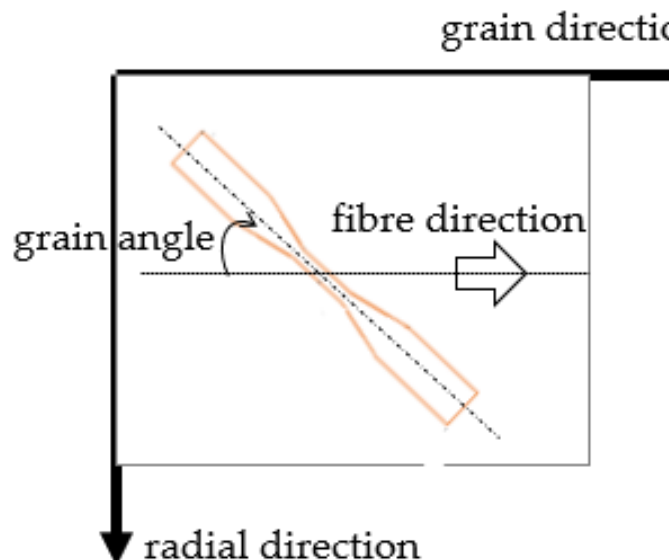
Figure 2. Cut method for Group II samples with grain angles of 10° and 45°.